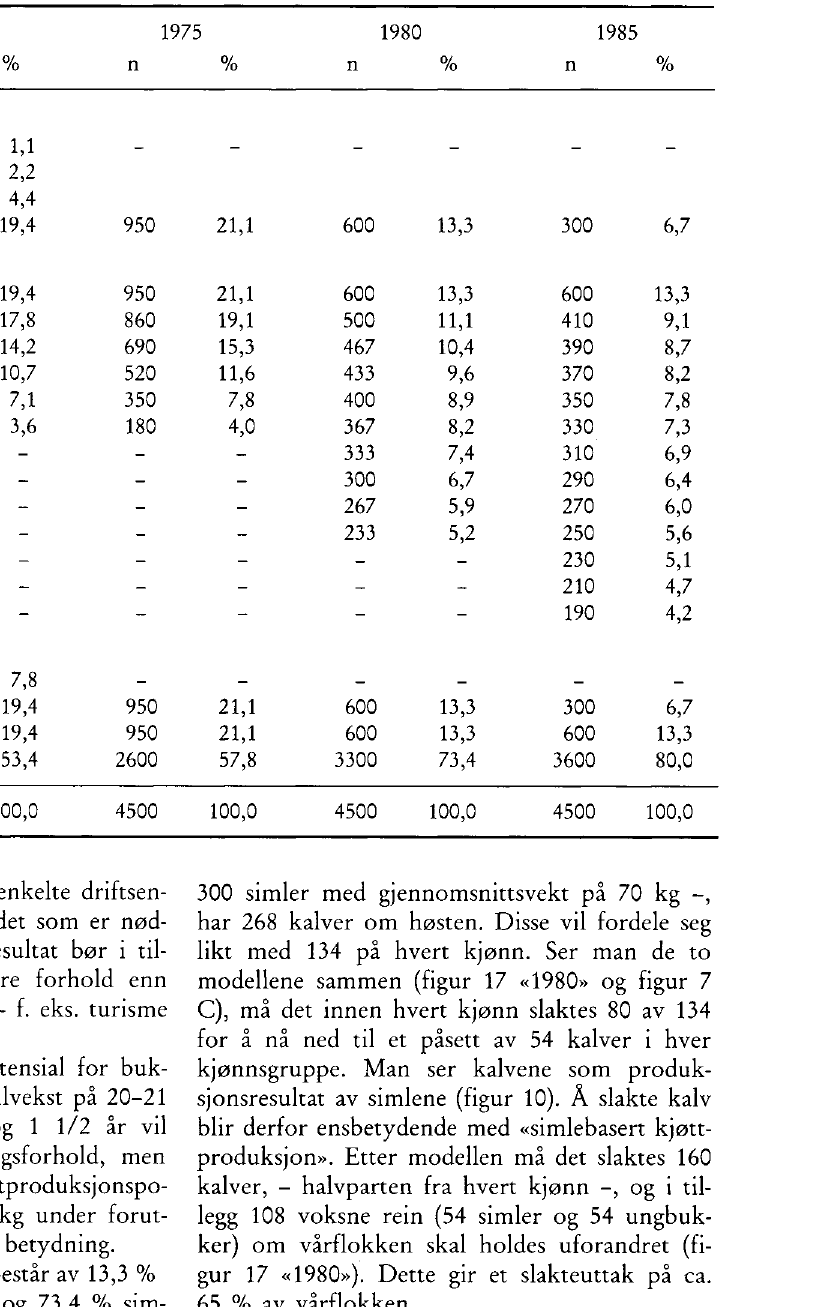
Tabell 2. Skjematisert sammenstilling (figur 17) over utviklingen av kjønns- og aldersstrukturen innen vårflok- ken i Riast/Hylling i perioden 1970-85 (Lenvik